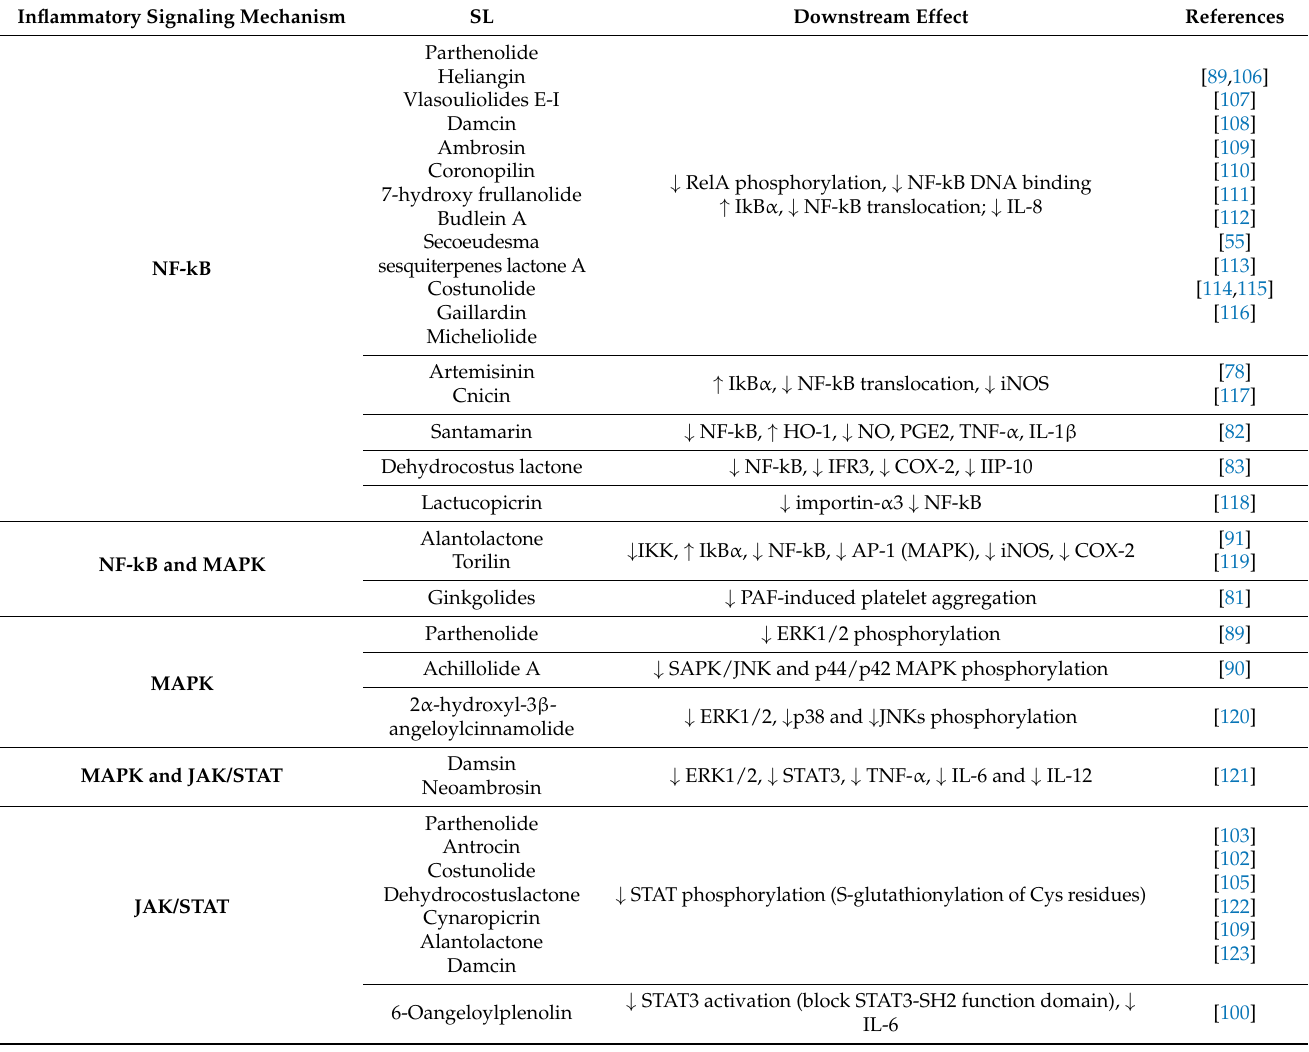
Table 2. SL described as having roles in inflammatory signaling mechanisms, namely NF-kB, MAPK, and JAK-STAT.